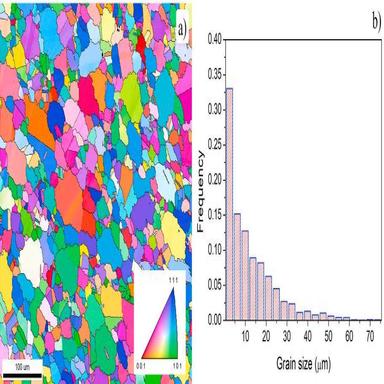
a) EBSD obtained colour IPF map of HIPed superalloy superimposed with high angle grain boundaries (solid black lines) with standard legend b) grain size distribution. (For interpretation of the references to colour in this figure legend, the reader is referred to the Web version of this article.)